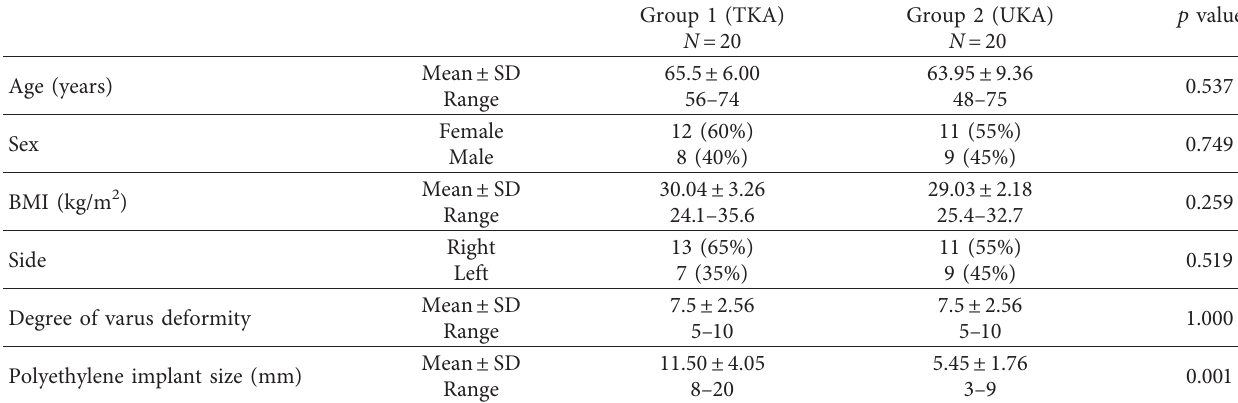
Table 1: Basic characteristics of the participants.